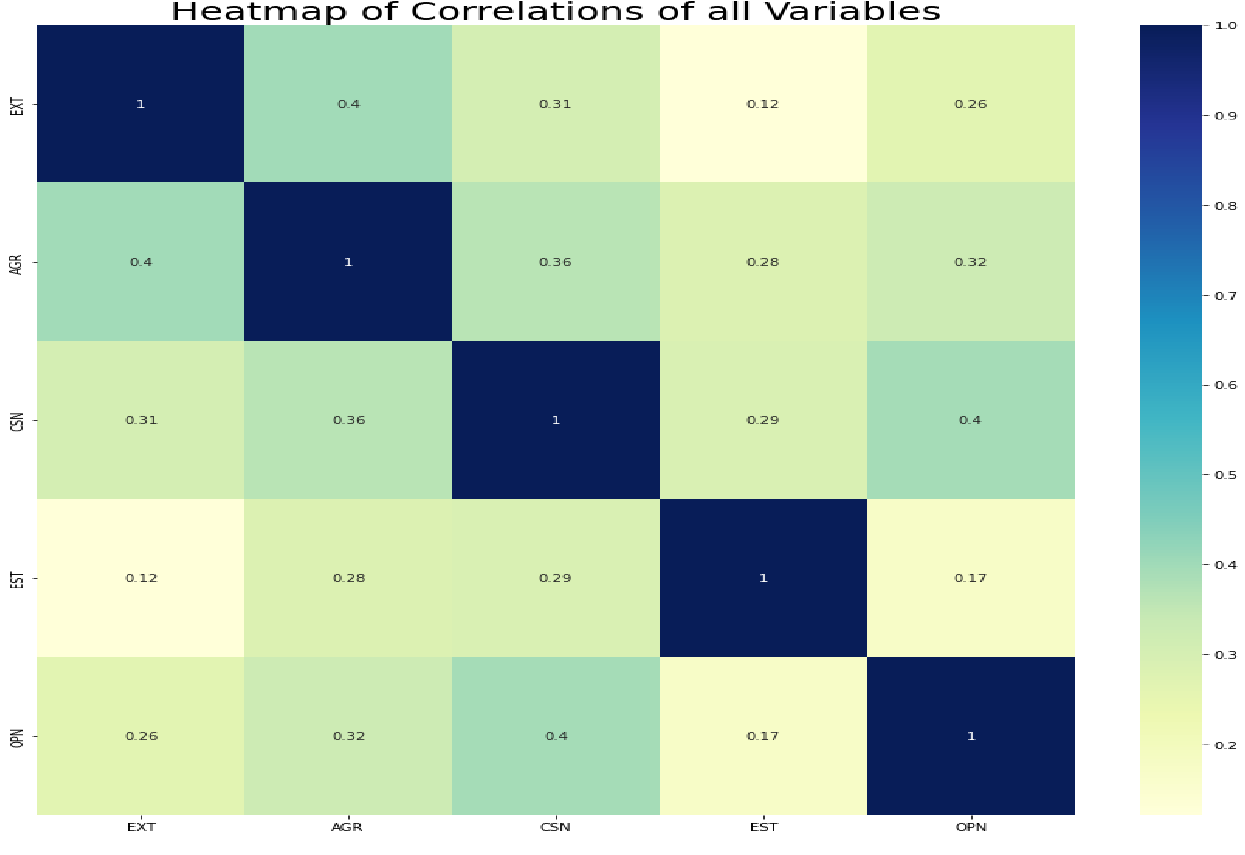
Table 1. Results of PCA.